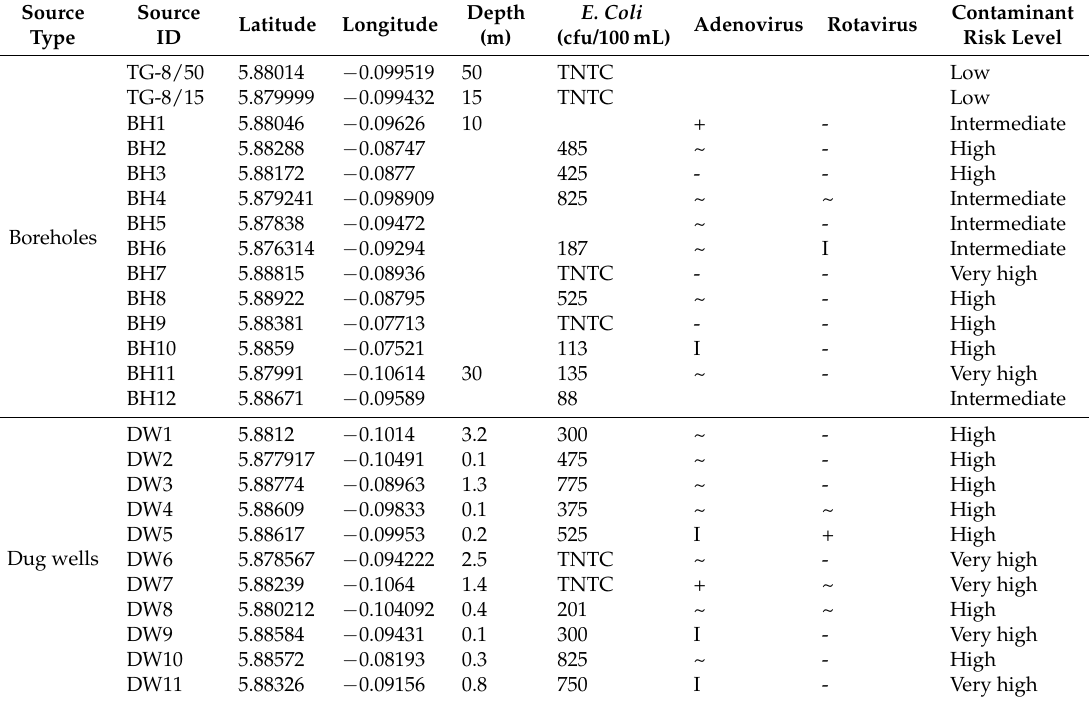
Table 2. Bacteriological quality, depth, and sanitary risk levels of groundwater